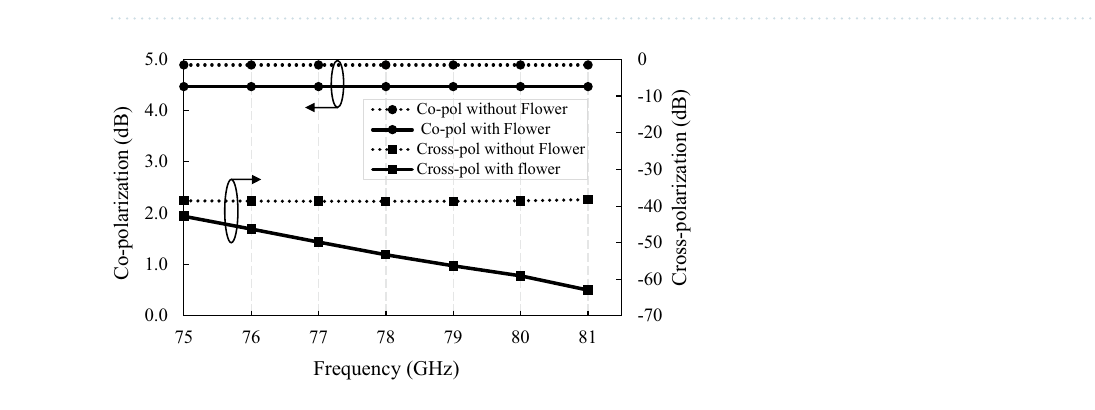
Figure 7. Normalized radiation patterns at three frequency points: 72.5 GHz (lower), 77 GHz (central), and 81 GHz (higher).